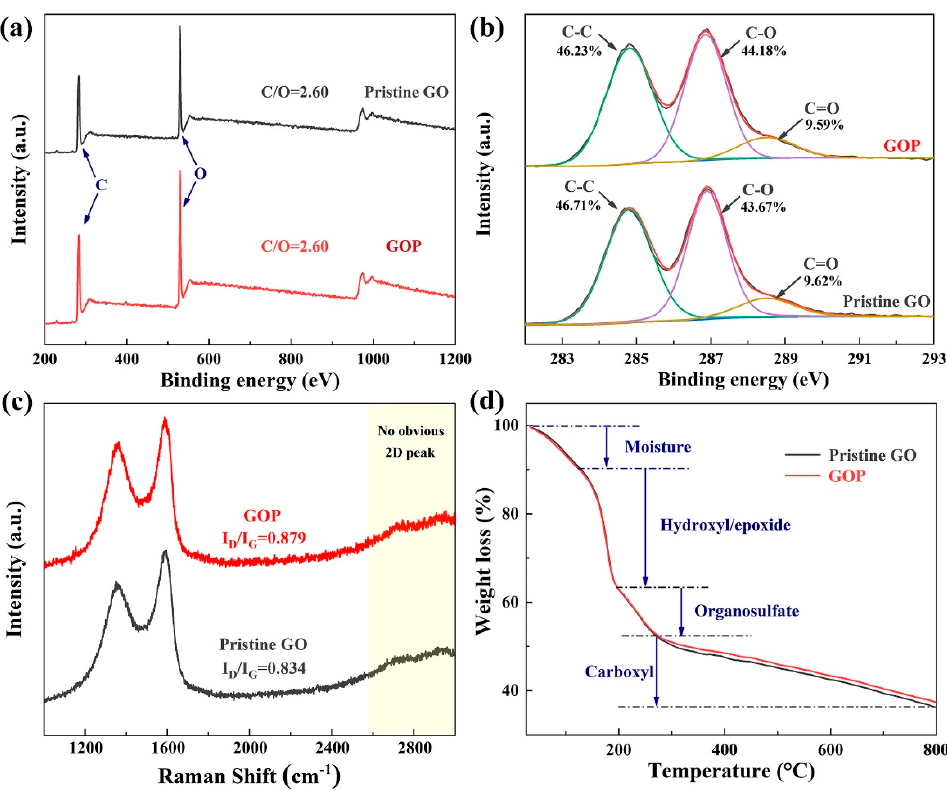
Figure 7. ( a ) Broad scan XPS spectra of the GOP and pristine GO. ( b ) XPS spectra for the C1s regions of GOP and pristine GO. ( c ) Reman spectra of the pristine GO and GOP. ( d ) TG curves of the GOP and pristine GO.